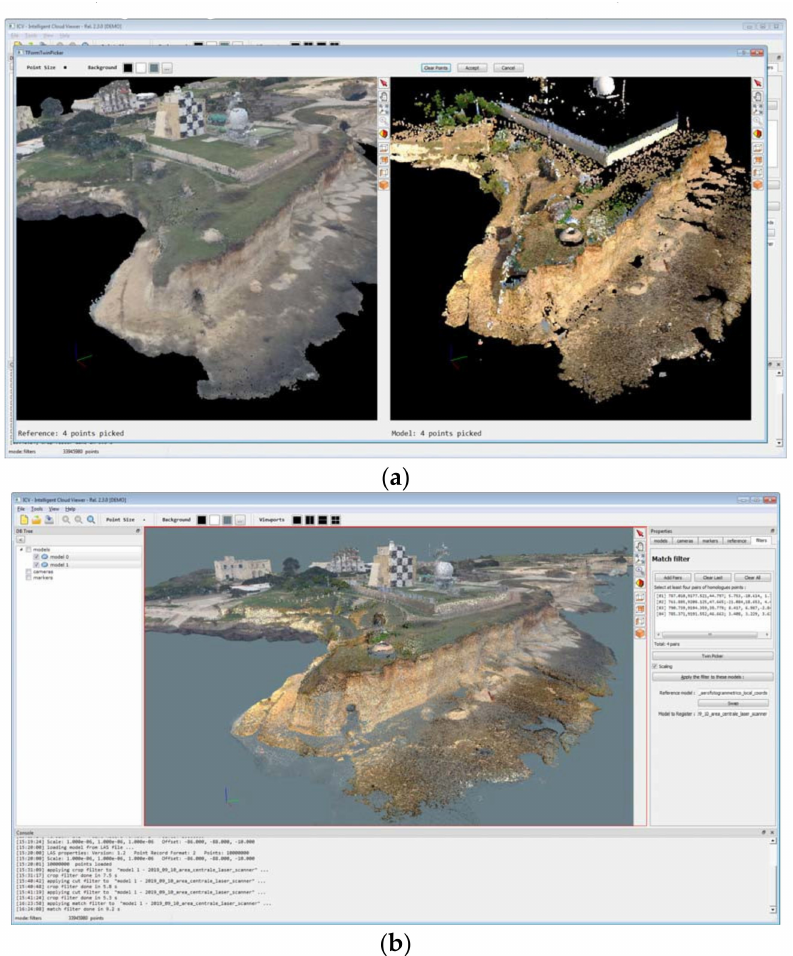
Figure 17. Course registration phase between aero-photogrammetric and TLS: ( a ) window for identifying duplicate points, ( b ) result of the process.